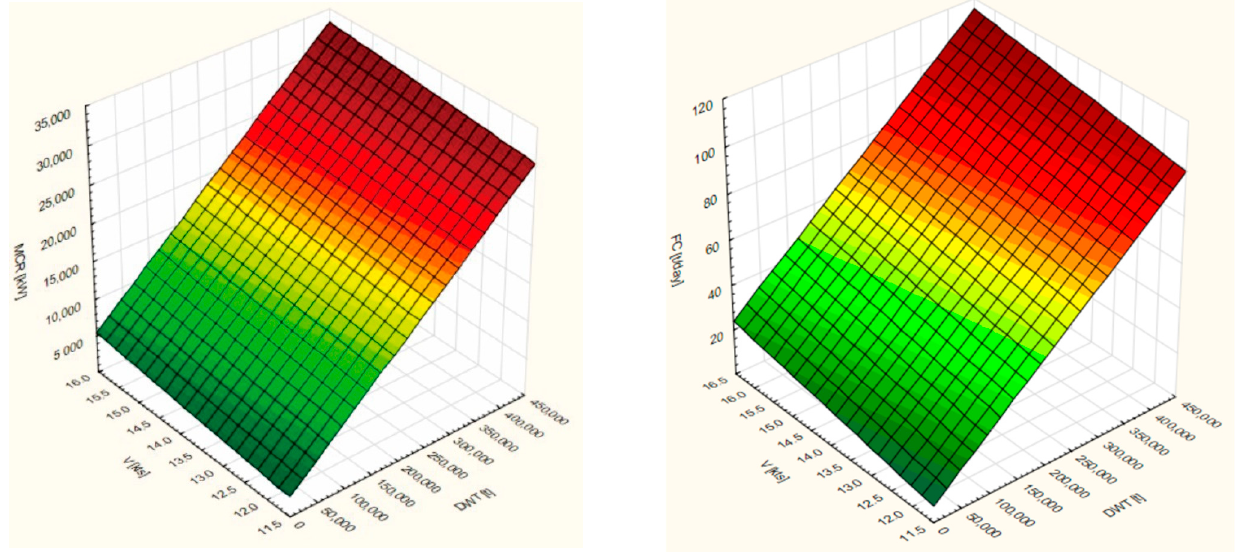
Figure 9. Estimated MCR and FC values in the full range of DWT and V calculated for bulk carriers by the use of Equations (7) and (8).